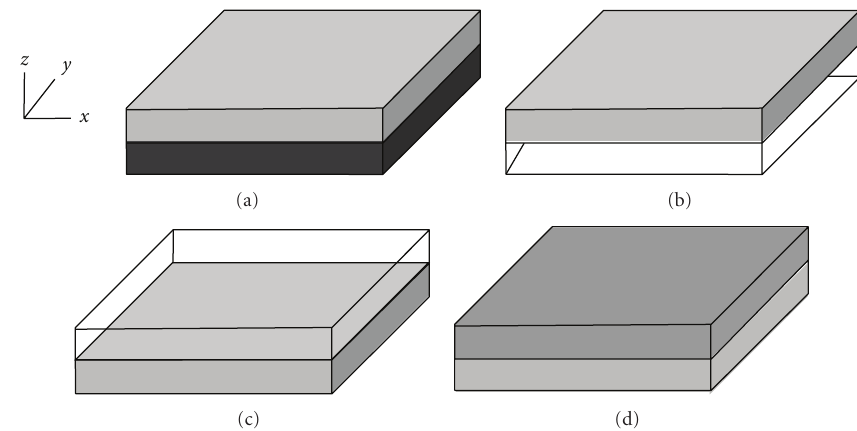
Figure 4: (a) the initial state of the shared memory. (b) after the plane z has been deleted. (c) the top tile ( z = 1) has been moved into the position of the bottom tile ( z ). (d) new data with the next z coordinate value is then loaded into the space created by moving the top tile. In each instance, the di ff erent shades of Gray represent di ff erent layers within the piece of data that we are reading from into shared